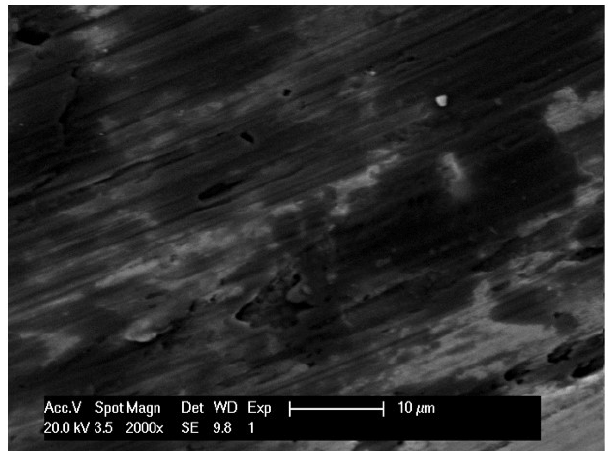
Table 1. Initial weight percent composition of stainless steel 316L.